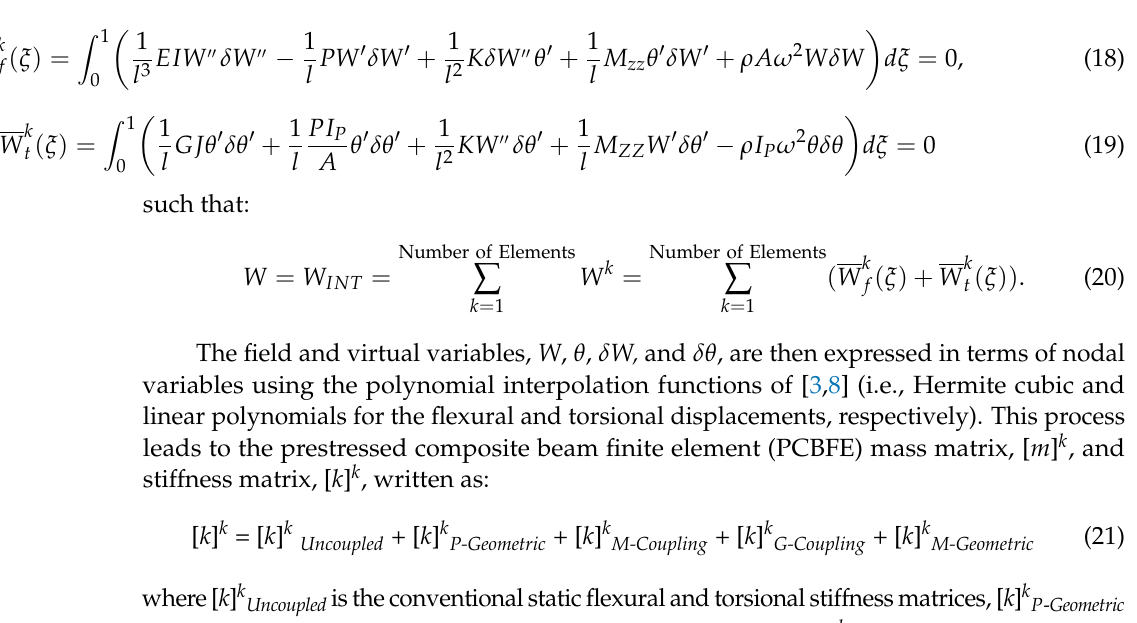
Figure 2. Discretized domain along the beam span using N elements and three DOFs per node .